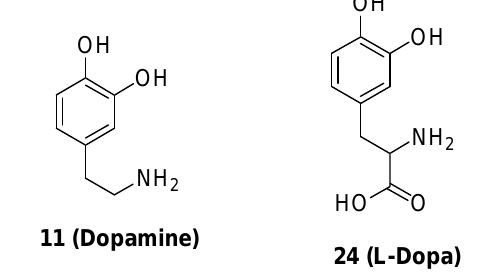
Figure 8. Chemical structures of dopamine and its prodrug L -DOPA as “pseudonutrient” for LAT 1